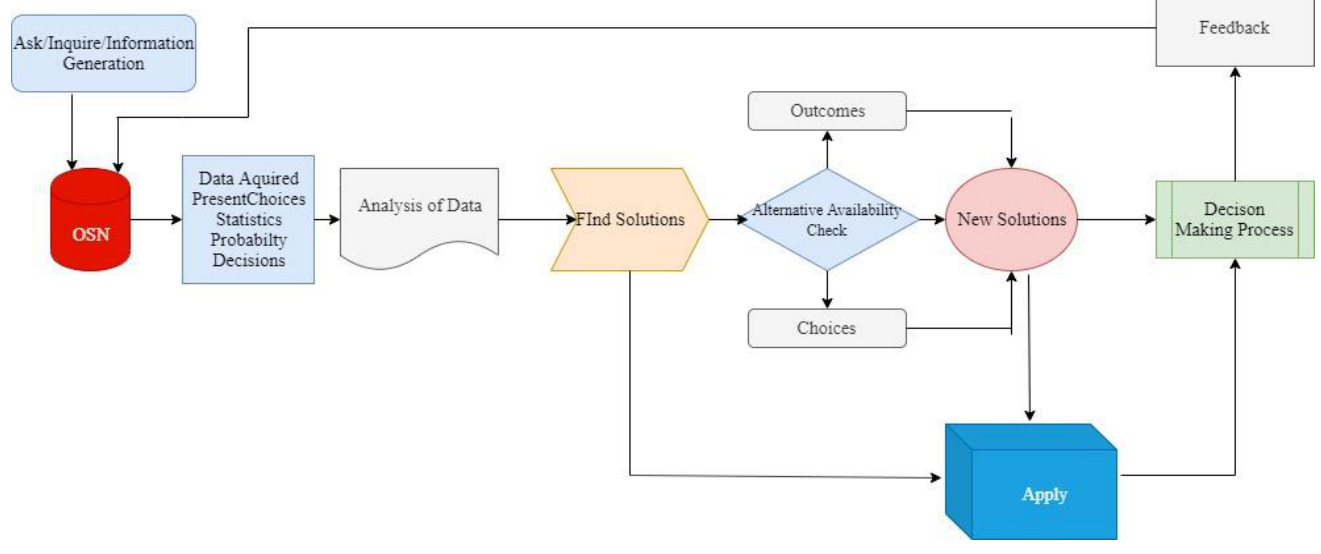
Figure 2. OSN architectural framework support decision-making